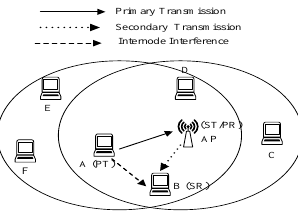
Figure 8. Inter-node Interference in Infrastructure Wireless